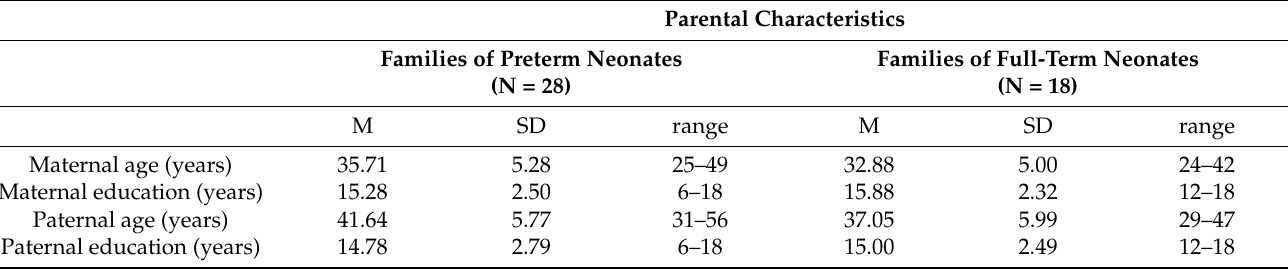
Table 2. Family demographic of the two groups of the